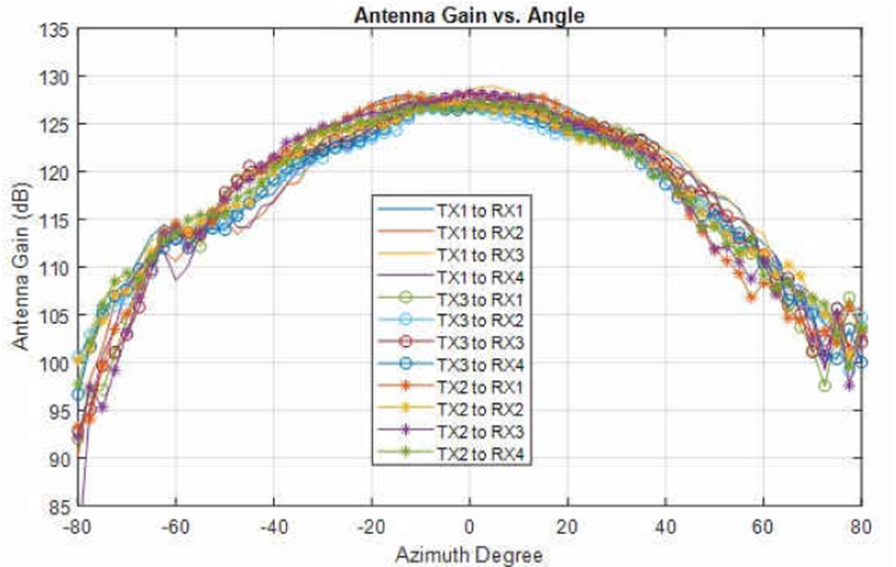
Figure 6. Radiation pattern for the pairs of TX and RX antennas (re-printed from [32]).